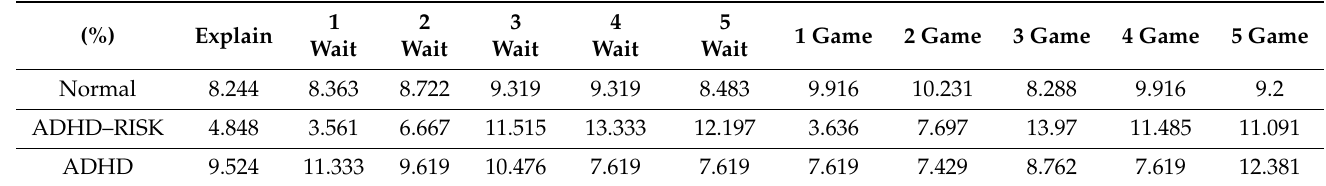
Table 5. Distribution rate of the top three attention scores for each stage and class of all children acquired through the channel attention layer.